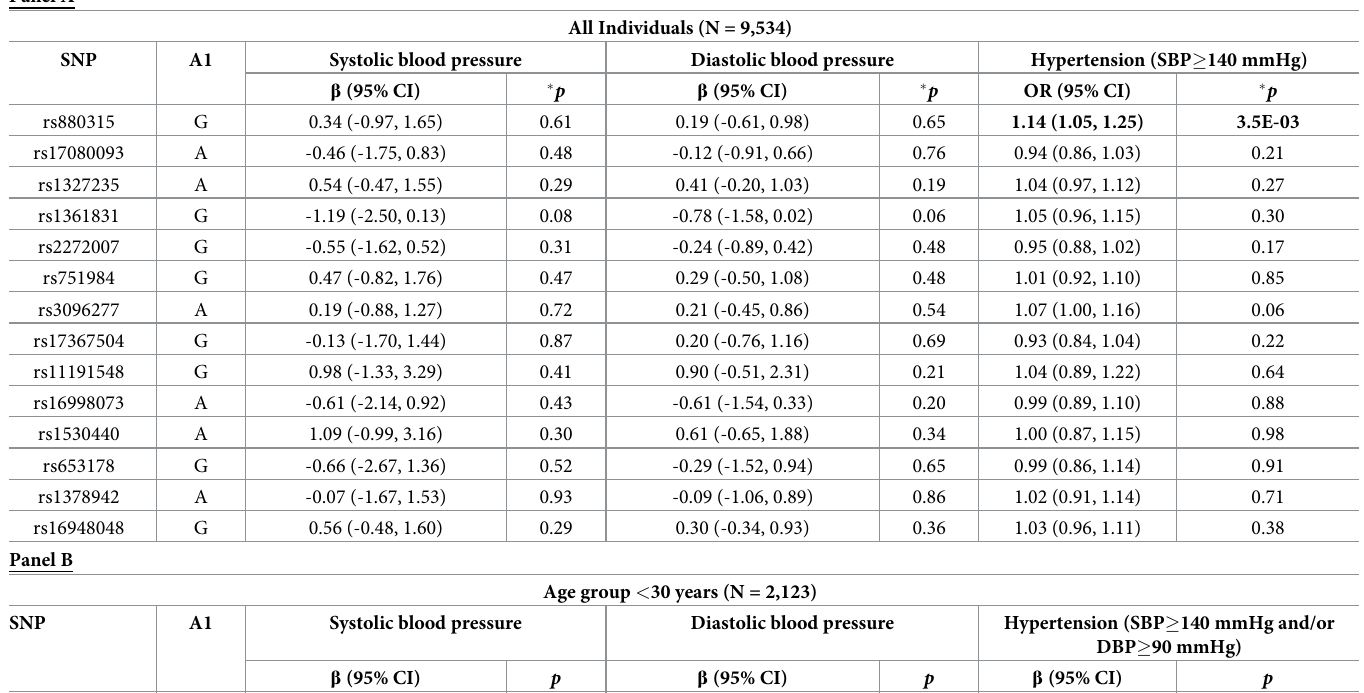
Table 3. Association of SNPs with blood pressure traits (SBP, DBP and hypertension) among all individuals with African-American ancestry. Panel